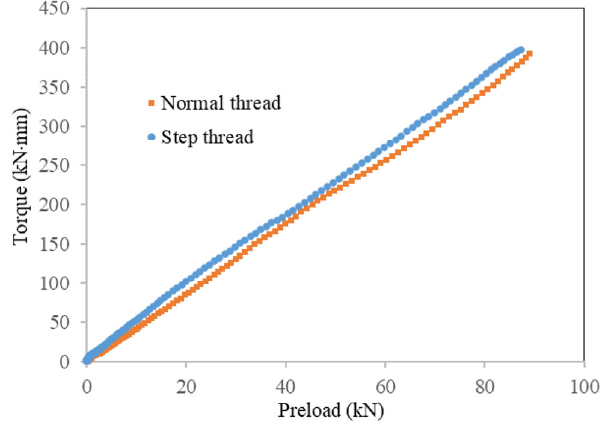
Fig. 21 Relationship curves between the input torque and preload.